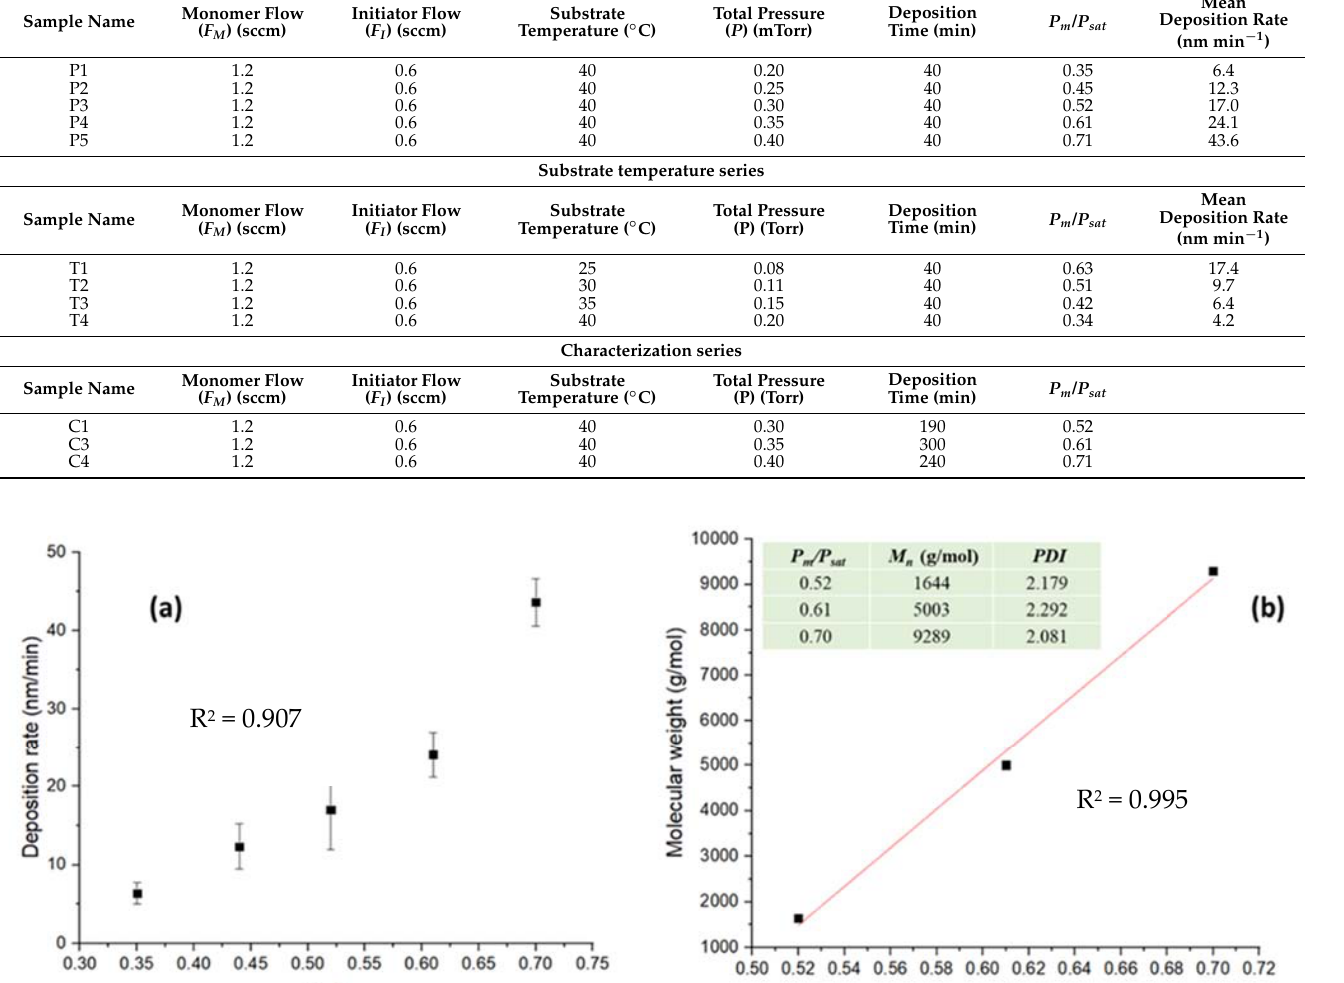
Table 1. Experimental conditions for iCVD of MBL on Si wafer substrate. The pressure series corresponds to Figure 2, and the substrate temperature series corresponds to Figure 3. Pressure series